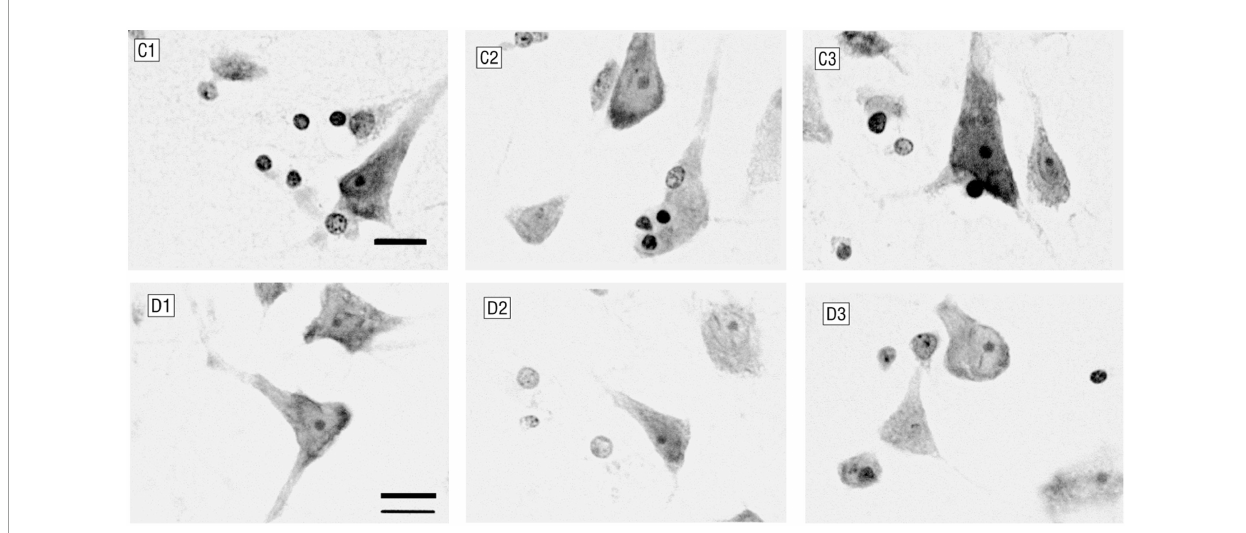
FIGURE1 Glial cells and neurons in layer 6 of the anterior cingulate cortex. C1–C3 were control subjects (male, 44 years old), and D1–D3 were patients with major depression (female, 52 years old). Patients with major depression had fewer glial cells and smaller neurons (Nissl staining; bar, 12 µ m).